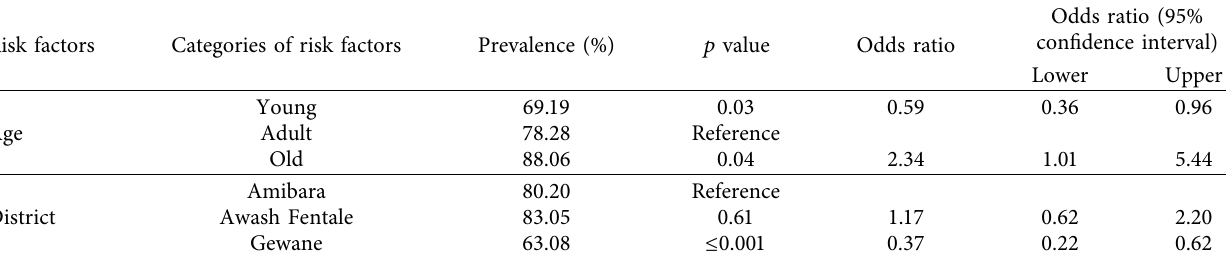
Table 4: Logistic regression analysis on degree of association between prevalence and potential risk